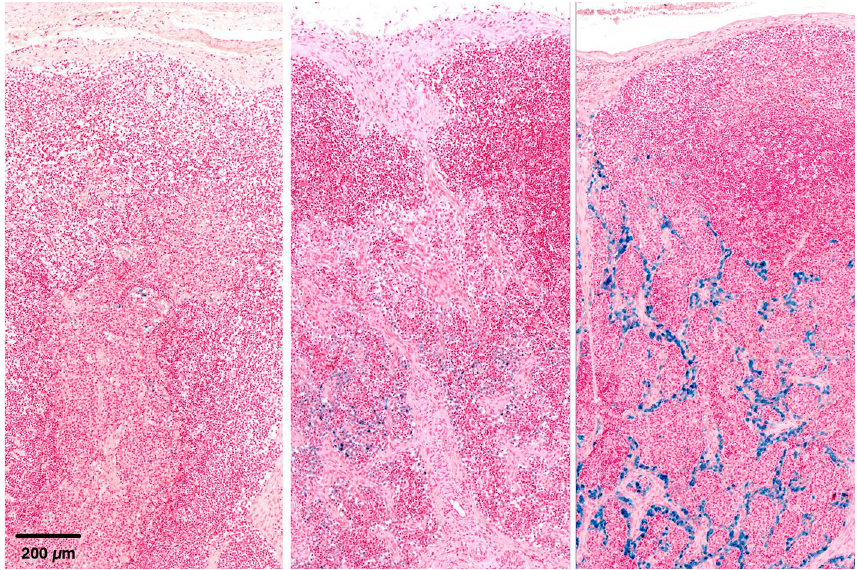
Figure 2. Iron-laden macrophages in the fibrous tissue adjacent to the implant. Adjacent to the macrophages are a low number of lymphocyte has accumulated around the small vessels. HE (left) and Turnbull blue staining (right).